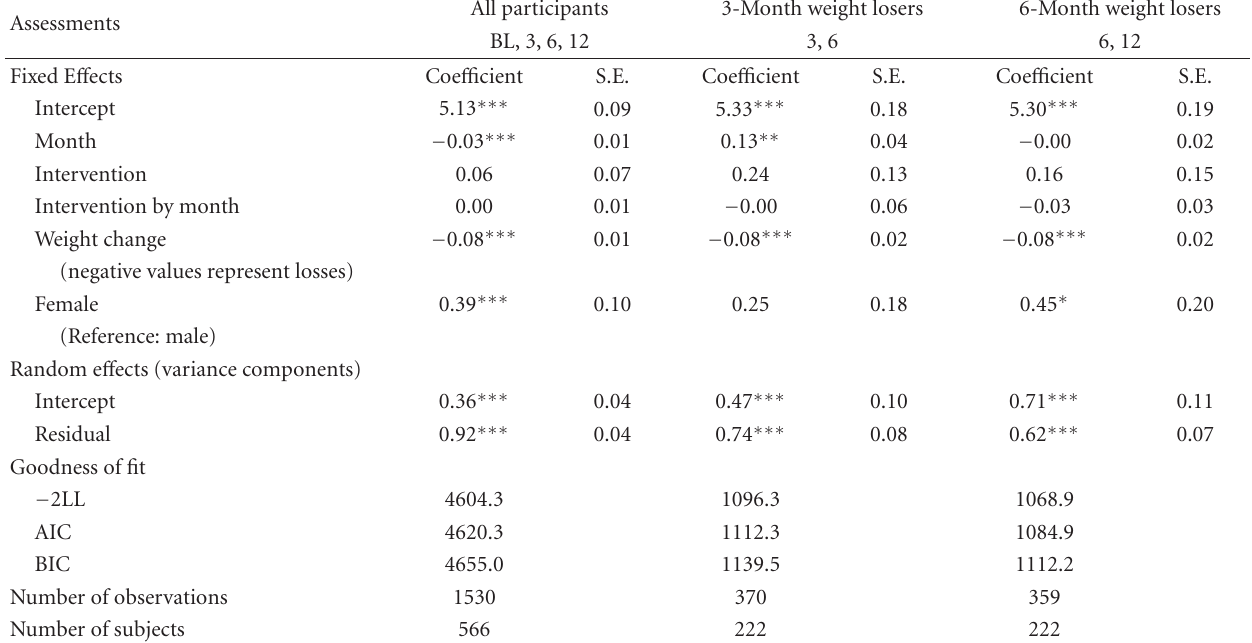
Table 3: Changes in autonomous motivation.